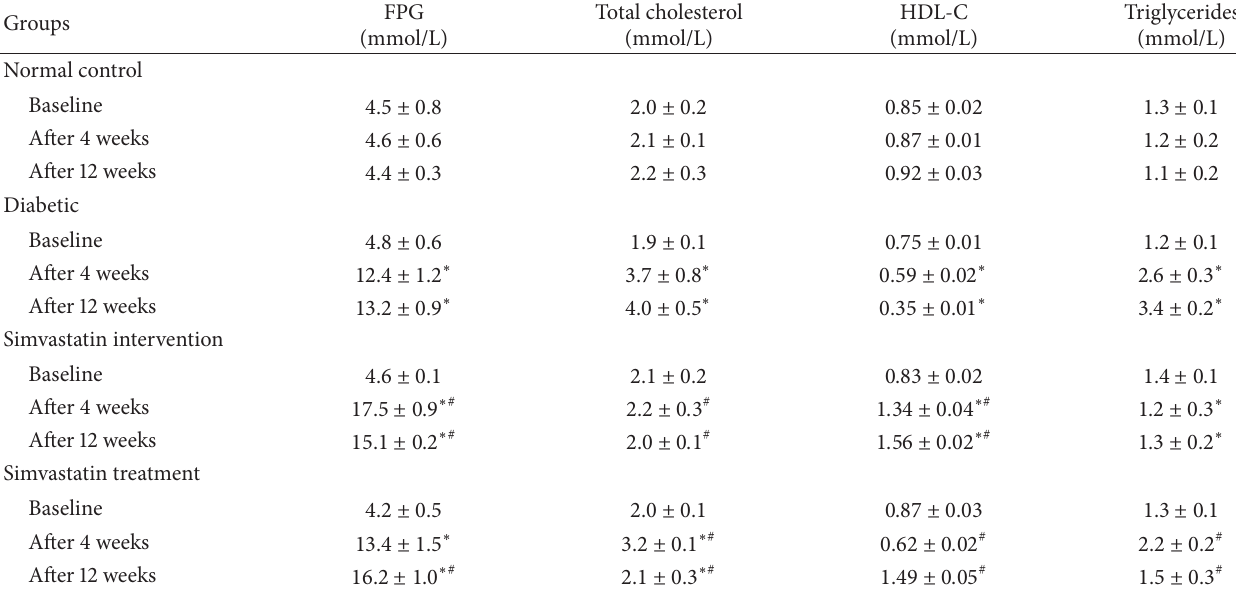
Table 2: Effect of intervention and treatment with simvastatin on fasting plasma glucose, serum total cholesterol, HDL-C, and triglycerides. Groups